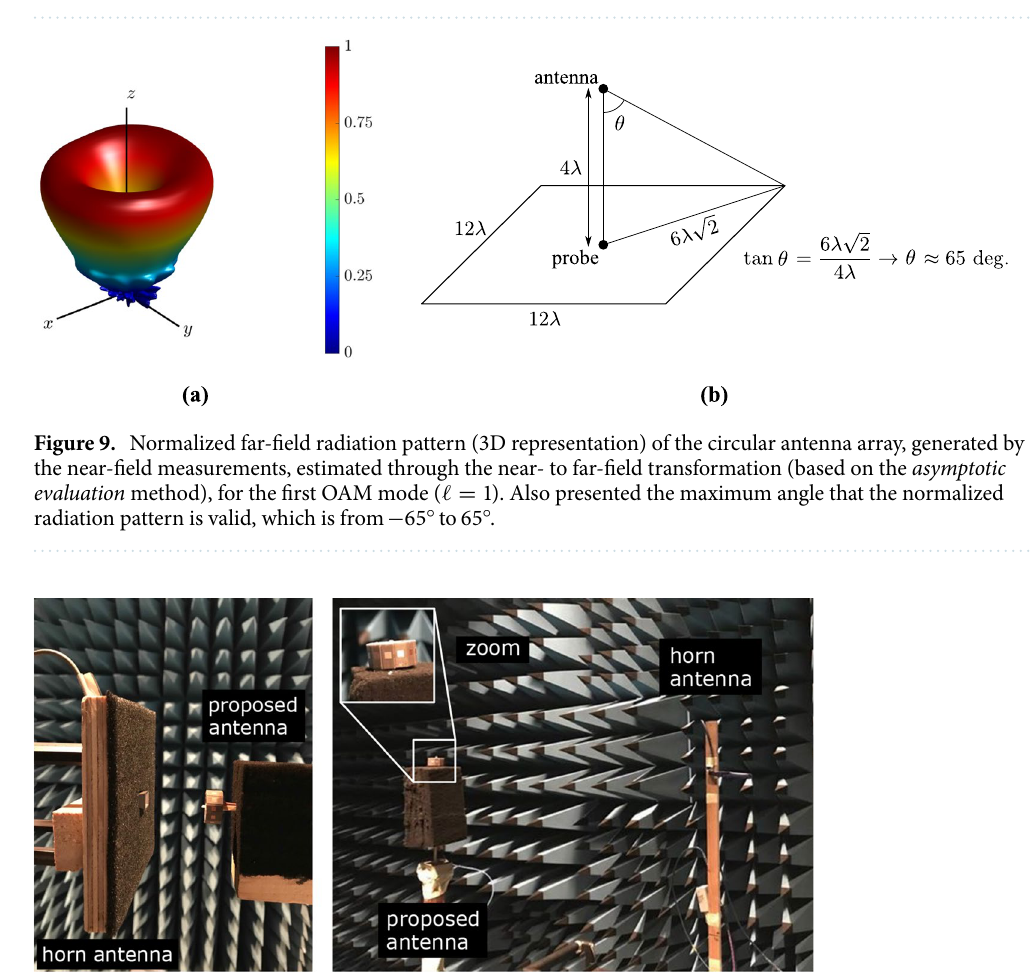
Figure 8. Comparison between simulated and measured near-field electric field patterns against OAM excitation for mode ( a ) ℓ = + 1 and ( b ) ℓ = + 2 : a good agreement is observed.